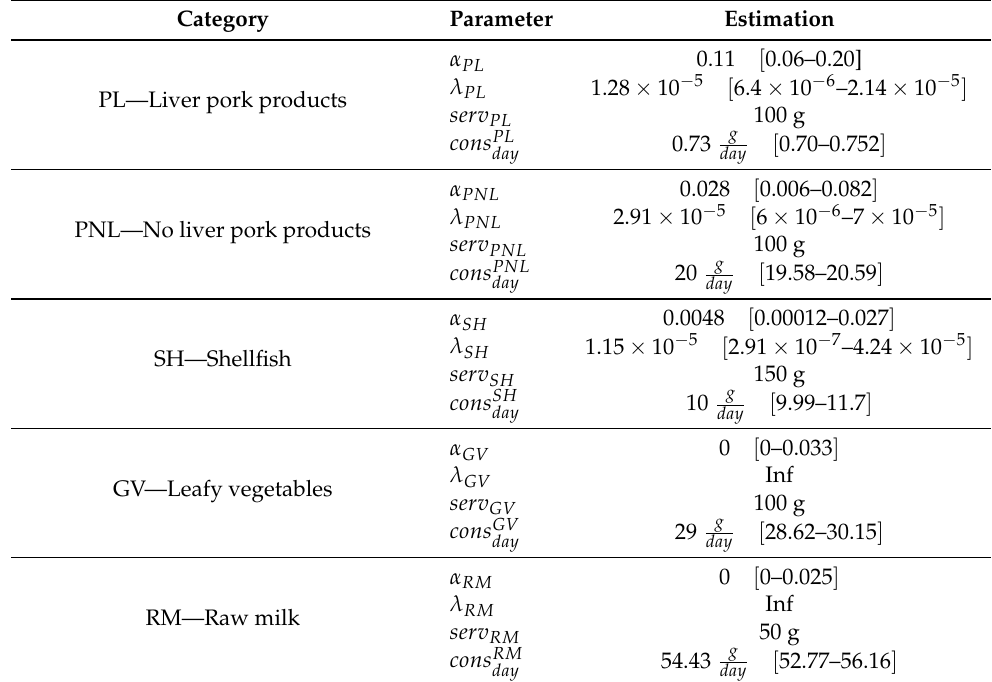
Table 3. Parameter estimations per food category. A 95% CI is reported between brackets.